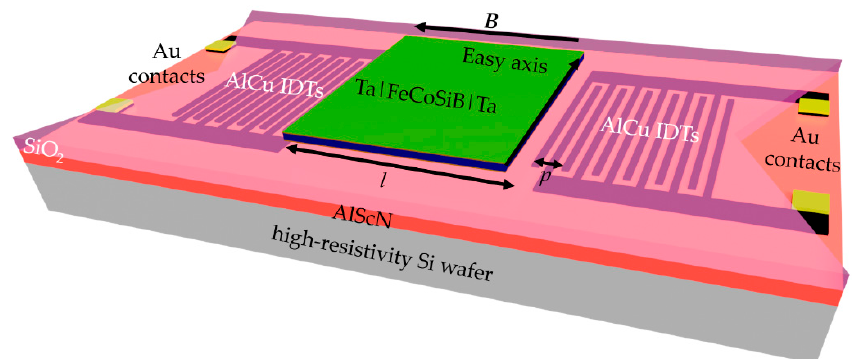
Figure 1. Schematic sketch of the SAW thin-film magnetic field sensor. Magnetostrictive FeCoSiB on top of the silicon dioxide layer of length l is in between the AlCu IDTs. FeCoSiB is capped with Ta to avoid corrosion. The easy axis of the magnetostrictive film defines the sensitive direction of the sensor against an external applied magnetic field B and is chosen to be perpendicular to the direction of SAW propagation. As the piezoelectric material, AlScN is chosen.